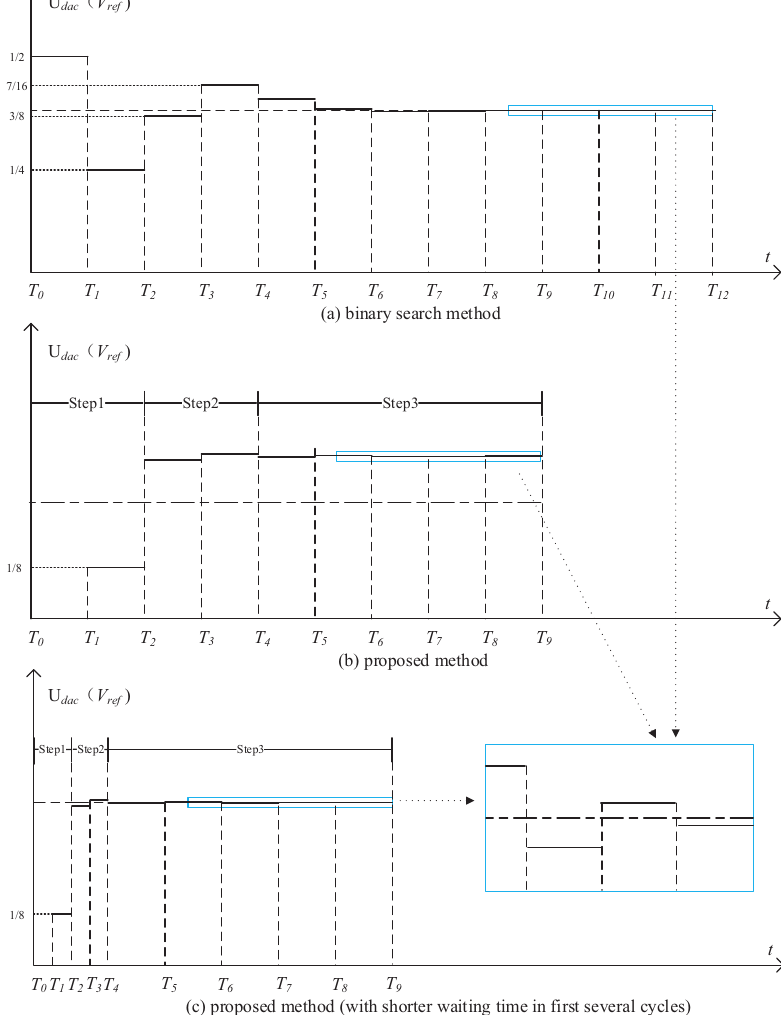
Figure 6. The differences between binary search and the proposed method. ( a ) Binary search method, the requiring measurement cycles are equal to the DAC bits. ( b ) Proposed method, reducing the measurement cycles by peak estimation (step 1) and bound determination (step 2). ( c ) Further reduction of measurement time by cutting the waiting time in first several